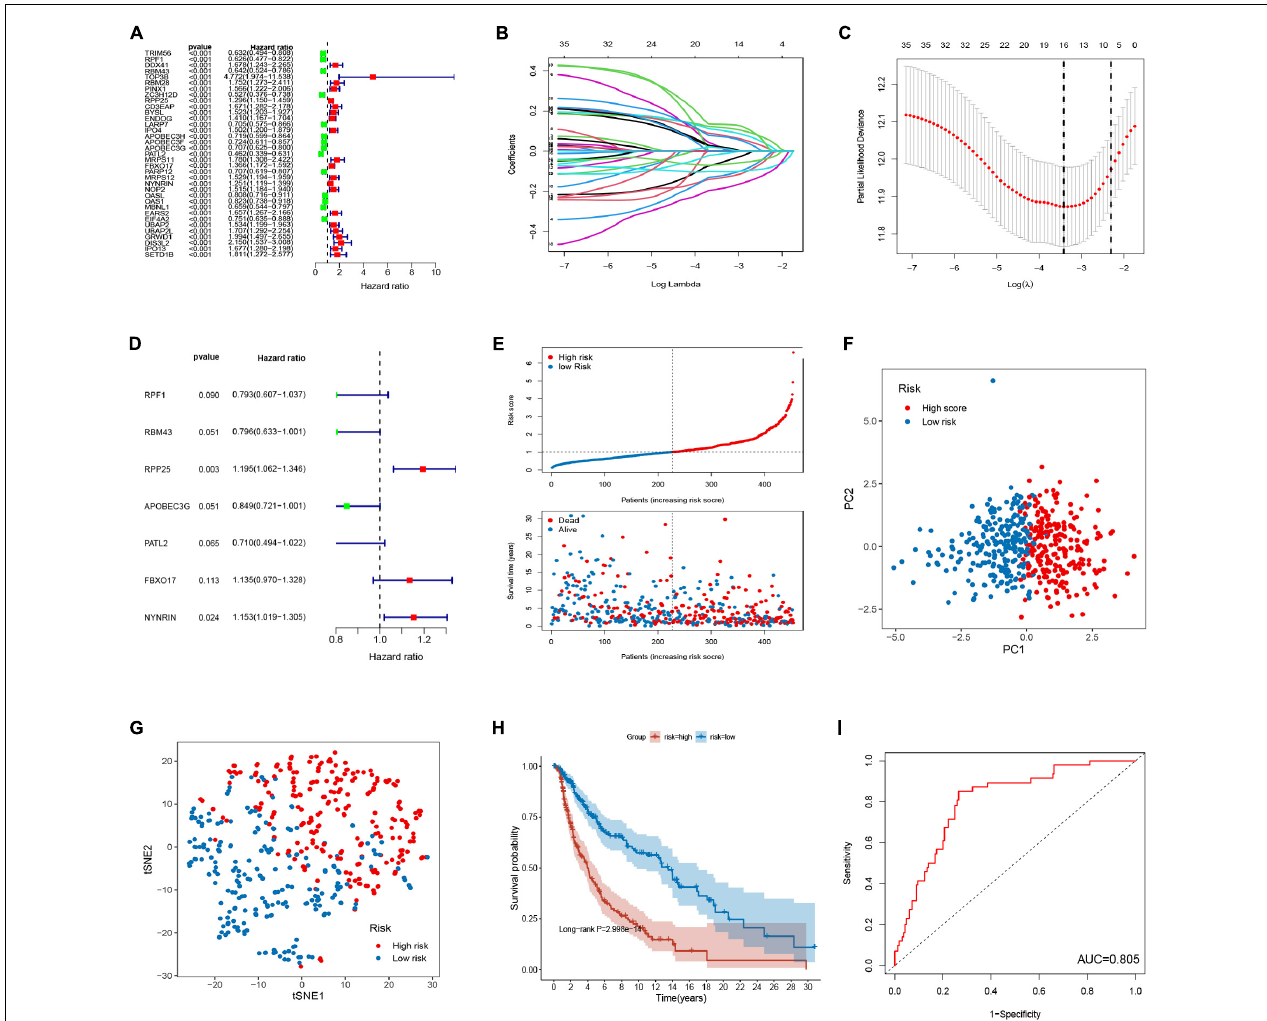
FIGURE 2 | Establishment of 7-RBP signature in TCGA dataset. (A) Forest plot of univariate Cox regression analysis for prognostic RBPs. (B,C) The LASSO regression analysis and partial likelihood deviance on the prognostic RBPs. (D) Forest plot of multivariate cox regression analysis for prognostic RBPs. (E) The ranked dot plot indicates the risk score distribution and scatter plot presenting the patients’ survival status. (F,G) The PCA and t-SNE analyses were performed between the two risk groups. (H) KM analysis of the OS between the two groups. (I) ROC curve of 7-RBP